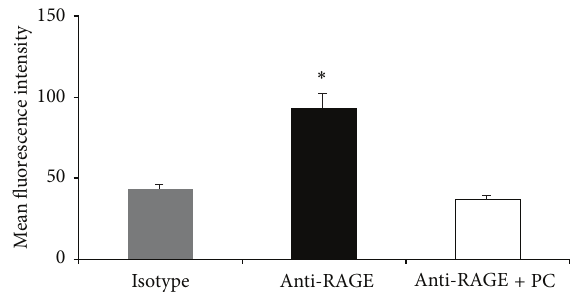
Figure7: Effect ofPCon intracellular RAGE expression inendothe- lial cells. Intracellular RAGE expression of TNF 𝛼 -stimulated (25 ng TNF 𝛼 /mL, 4 h) endothelial cells was measured by flow cytometry after permeabilization with saponin in response to PC (5U/10 6 leukocytes, 3h) and compared to respective isotype controls. Mean fluorescence intensities are presented as mean ± SEM from at least three mice per group. Significant differences ( 𝑃 < 0.05 ) to isotype and anti-RAGE + PC are indicated by the asterisks.